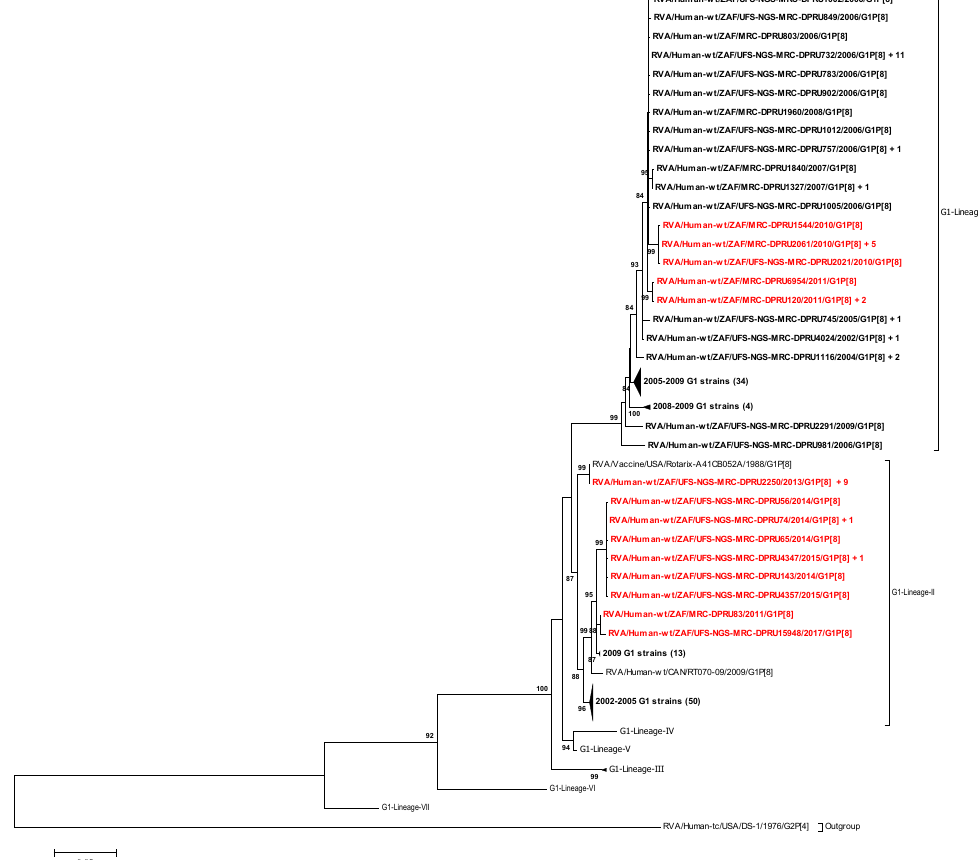
Figure 1. Maximum likelihood phylogenetic tree based on the full-length nucleotide sequences of genome segment 9 encoding the VP7 protein. The T92 + G evolutionary model was used for phylogenetic inference. South African pre-vaccine G1 strains are highlighted in bold-face while post-vaccine strains are highlighted in bold-red. Adjacent to some sequences is indicated a plus (+) sign followed by the number of identical sequences (S3). The number in brackets denotes the number of compressed strains. Lineages are indicated in roman numerals. Only bootstrap values ≥ 70% are shown adjacent to each branch node. Scale bar indicates the number of nucleotide substitutions per site. Table 1. Nucleotide identity analysis between South African pre- and post-vaccine G1P[8] strains, pre-vaccine G1P[8] strains with Rotarix ® , and post-vaccine G1P[8] strains with Rotarix ® strain. Gene Segments / Nucleotide Identity